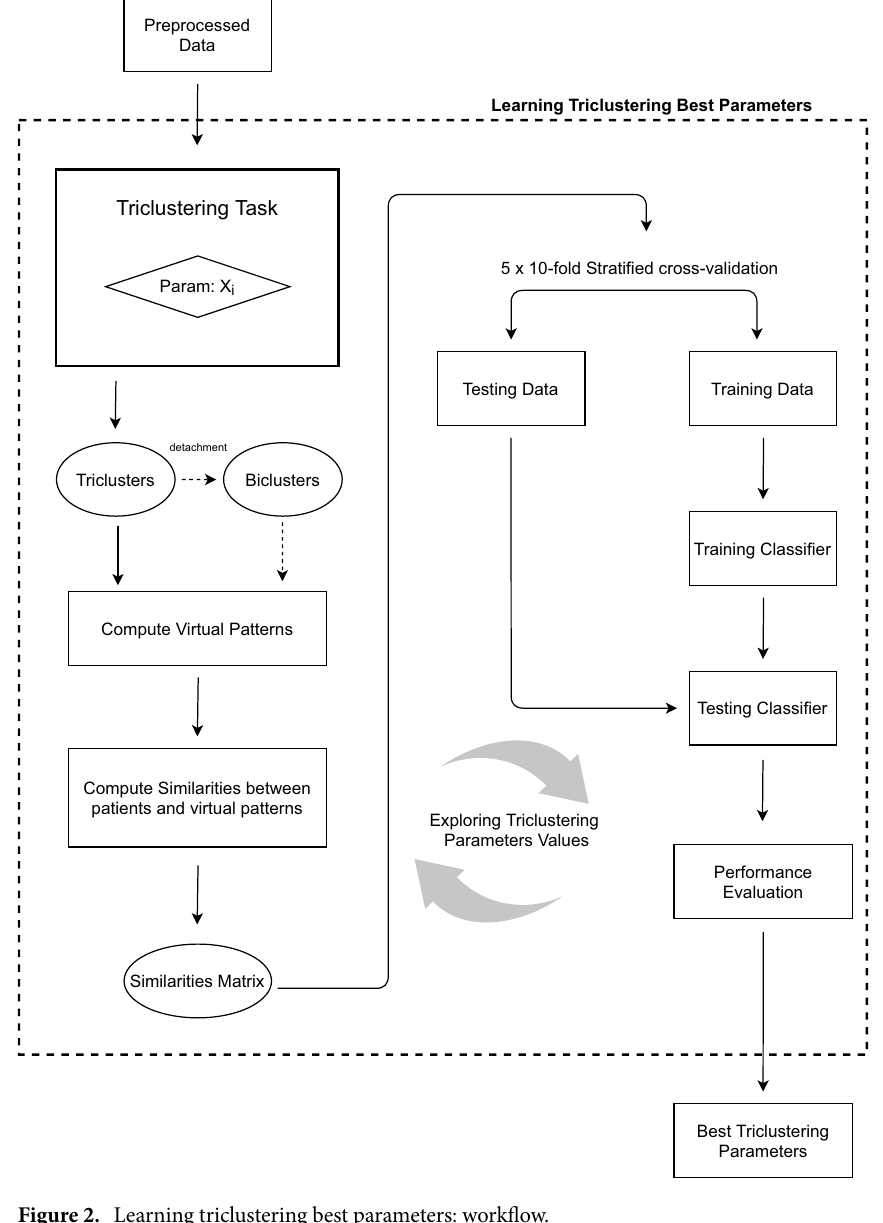
Figure 2. Learning triclustering best parameters: